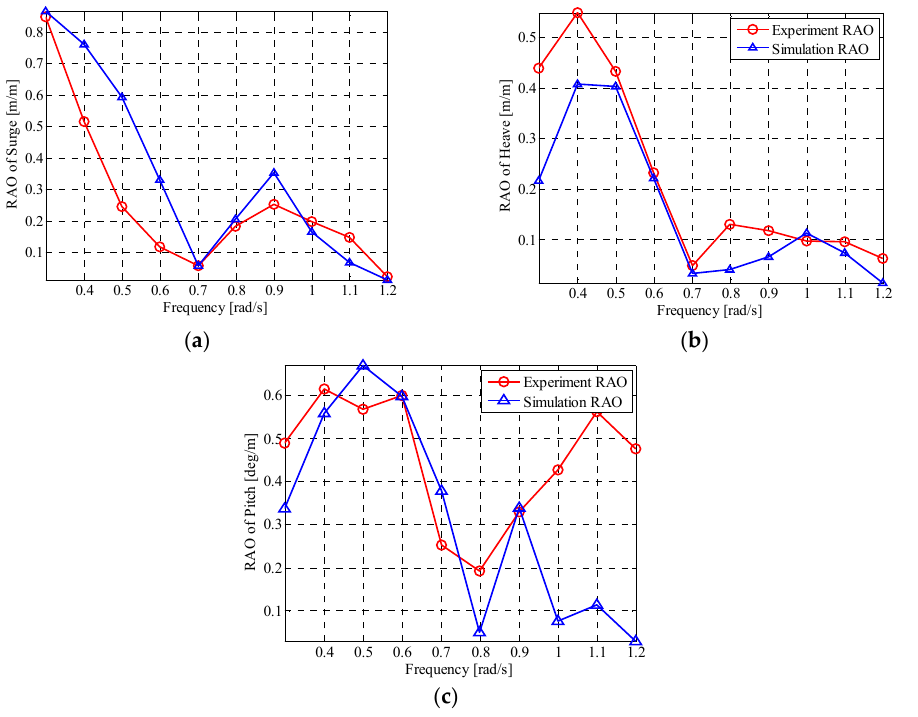
Figure 11. ( a ) Surge RAO curves of the scale model test and numerical simulation of the platform; ( b ) heave RAO curves of the scale model test and numerical simulation of the platform; ( c ) pitch RAO curves of the scale model test and numerical simulation of the platform.